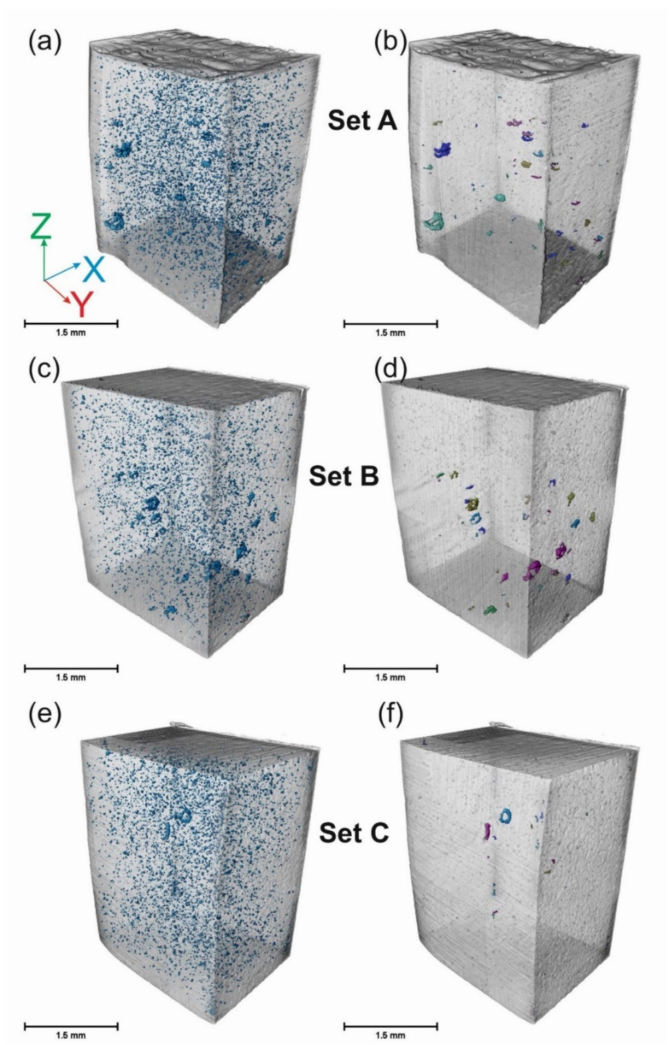
Figure 4. A 3D constructed image of a part of impact specimens (15.5 mm 3 ) fabricated via ( a , b ) Set A, ( c , d ) Set B, and ( e , f ) Set C, using X-ray micro-computed tomography (Micro-CT). Specimens ( a , c , e ) in- clude all defects, while ( b , d , f ) isolate LoFs. All the samples contained border and core